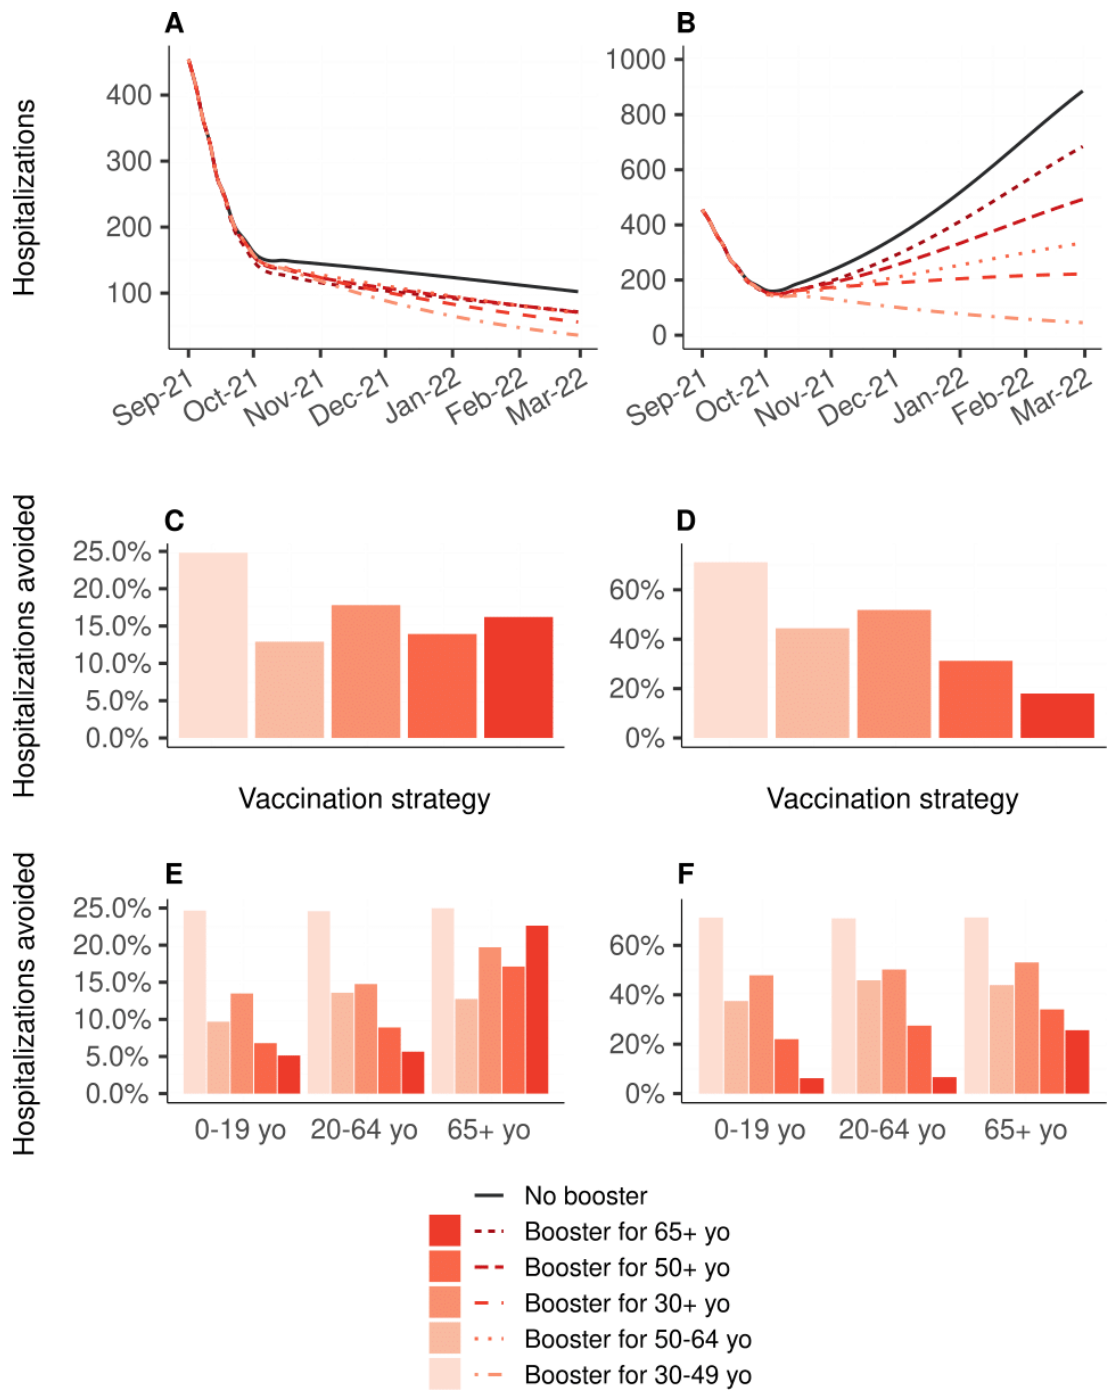
Figure 2. Impact on the hospital admissions of 10 million booster shots depending on the targeted age groups, over the period from 1 September 2021 to 1 March 2022, compared to a baseline scenario of no booster shots. In all strategies, primary vaccination is stopped on 1 September 2021. ( A , C and E ) Vaccine efficacy decreased only for people aged 65 years and older. ( B , D and F ) Vaccine efficacy decreased for all age groups. ( A , B ) Daily new hospitalizations, ( C , D ) proportion of hospitalizations avoided, ( E , F ) proportion of hospitalizations avoided by age group.